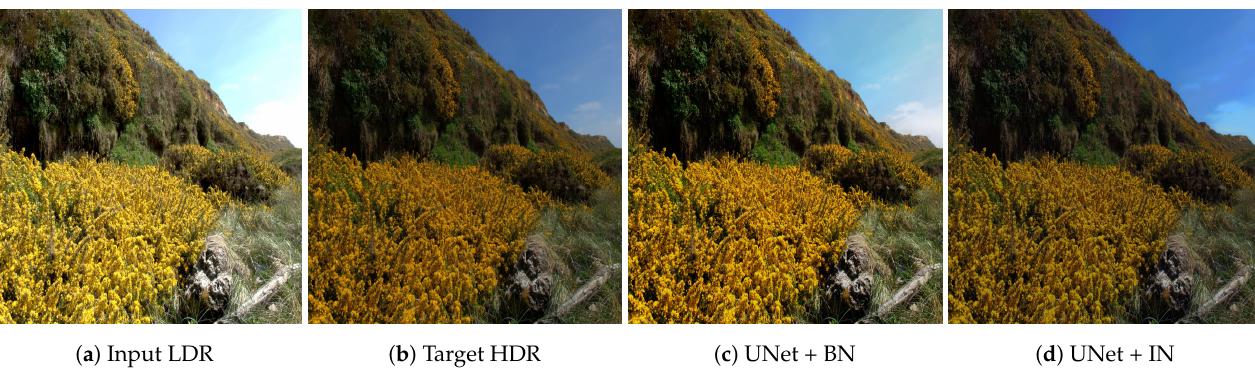
Figure 10. Effect of batch normalisation and instance normalisation. Instance normalisation predictions are closer to the target HDR in